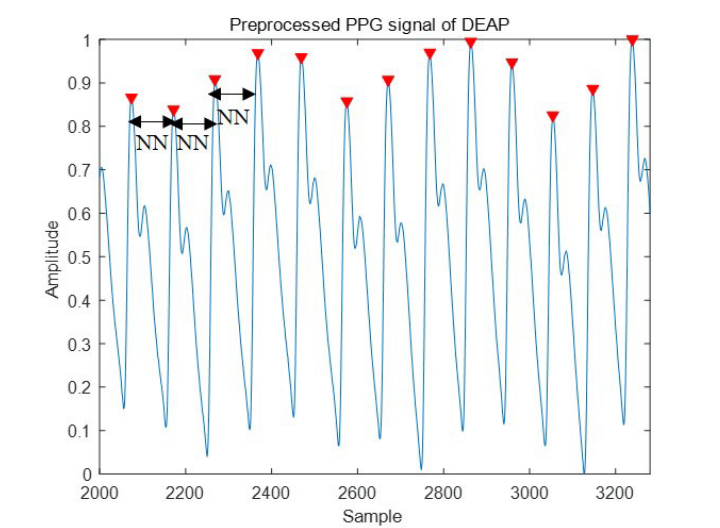
Figure 4. Baseline removal of the PPG signal.